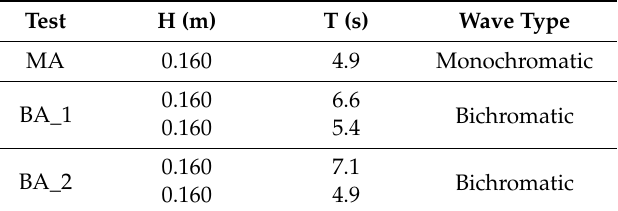
Table 1. Wave characteristics for accretive conditions.